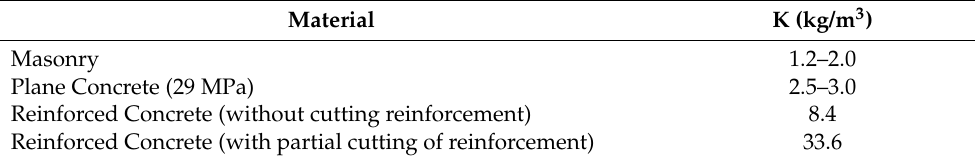
Table 3. Values of Specific charge weight, K [14].